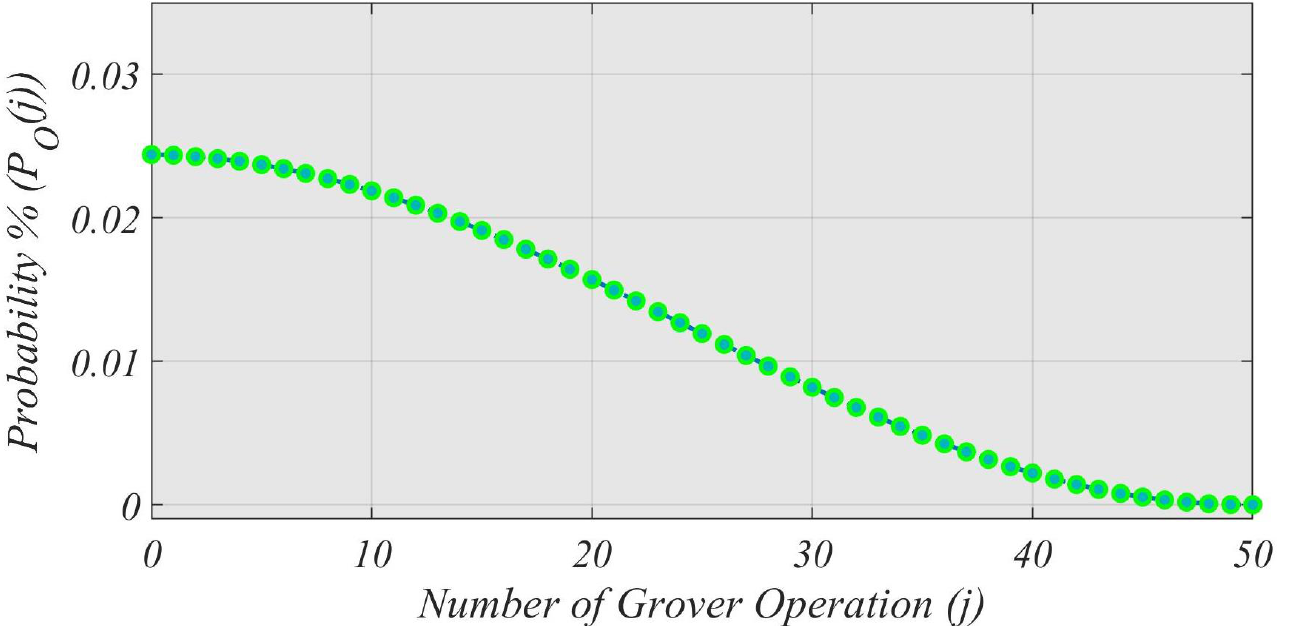
Figure 7. The probability of the state | 100001111000 (cid:105) after j Grover